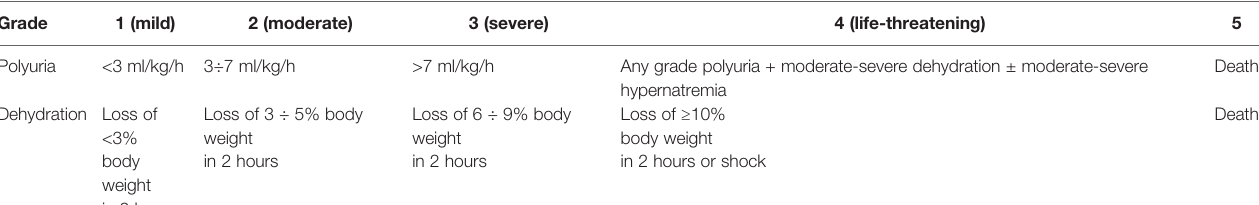
TABLE 3 | Suggested classi fi cation of polyuria and dehydration in the ICI-induced CDI